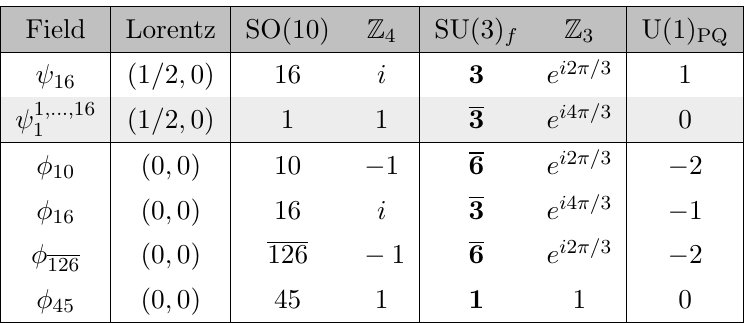
Table 1 . Field content of the model and relative transformation properties under SO(10) Z its Z 4 3 center and the accidental U(1) PQ . In light gray, exotic fermions which ensure SU(3) (cid:2) anomaly cancellation (cf. section